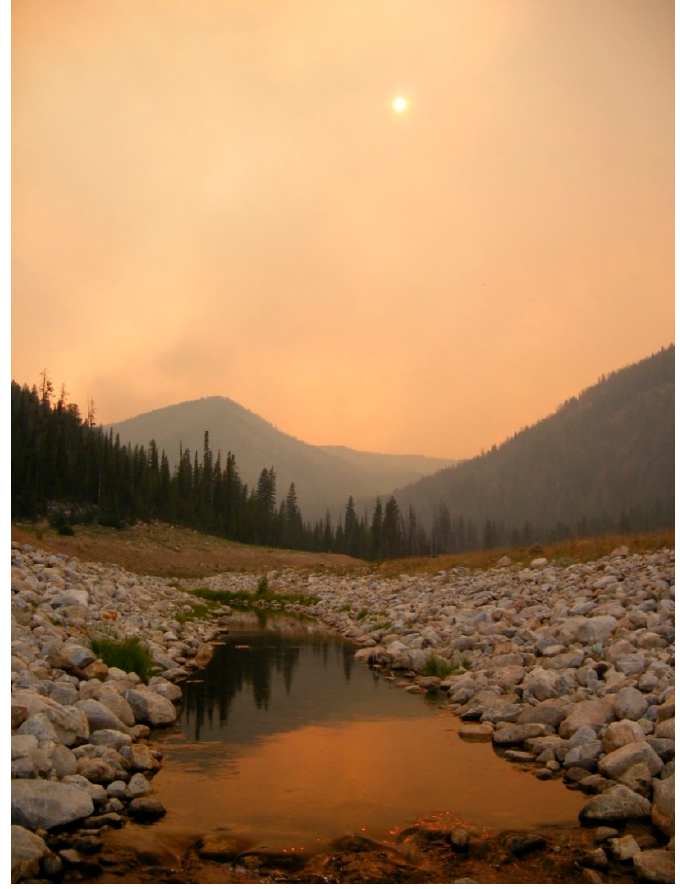
Figure A2. LH-reach in summer 2007. Photo by Robert Arkle.